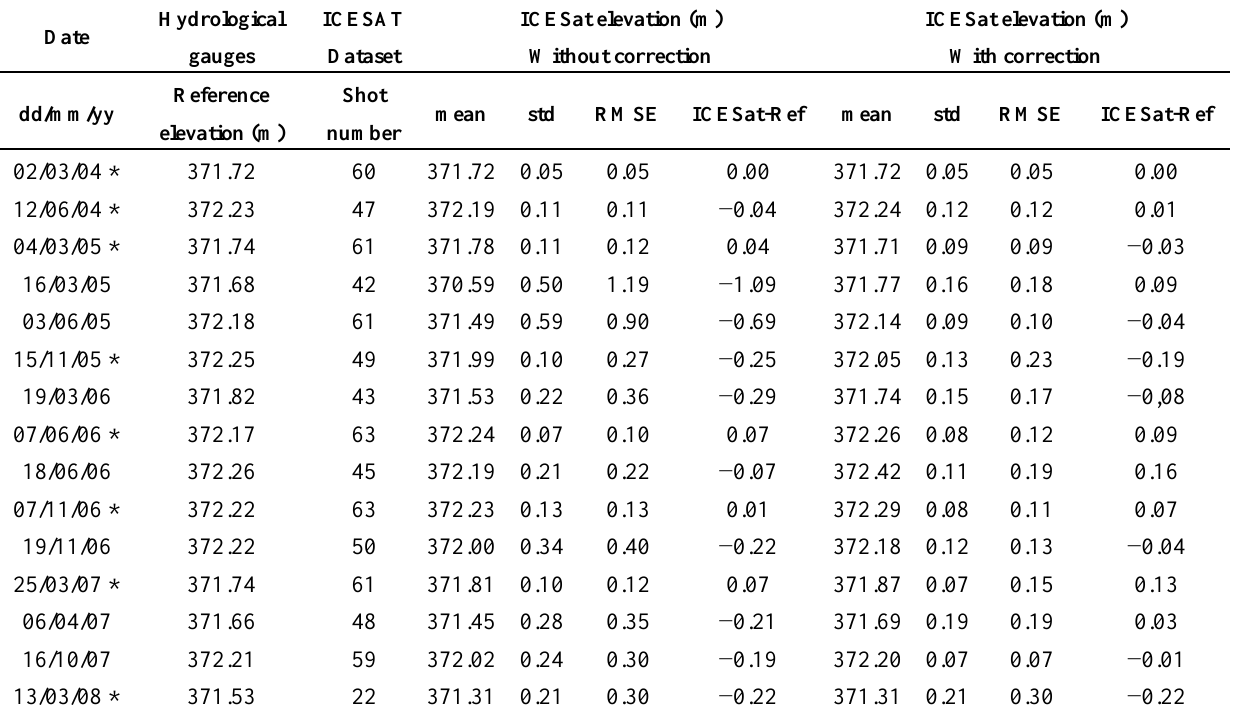
Table 1. Comparison of Geoscience Laser Altimeter System (GLAS) and reference elevations (hydrological gauges) for Lake Leman. The eight dates marked by a star (*) have weak or null saturation